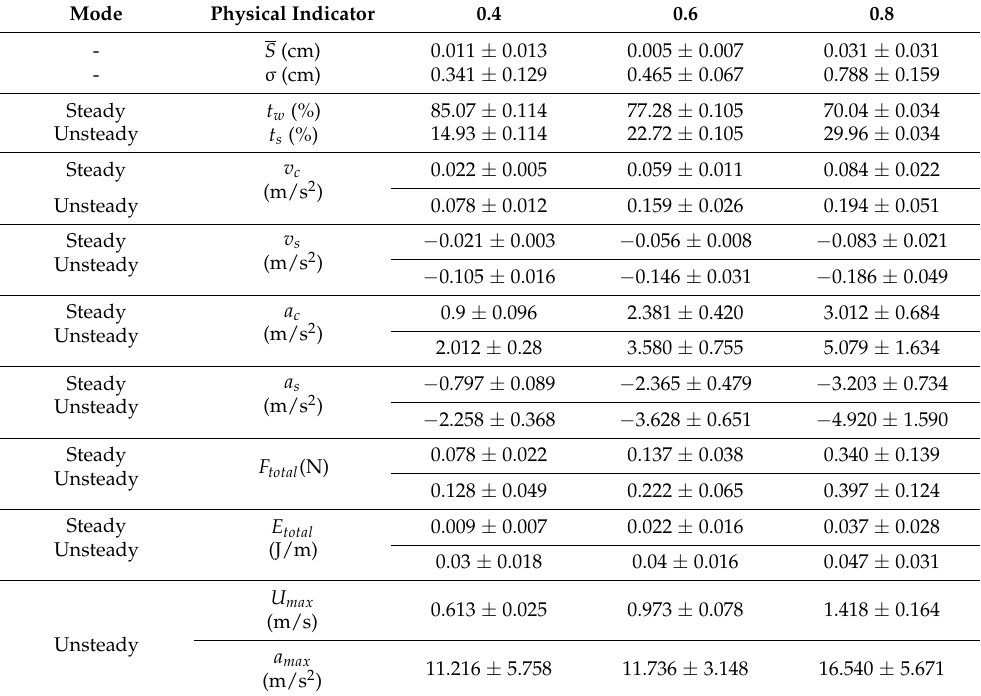
Table 4. Physical variables used to analyze S. malacanthus